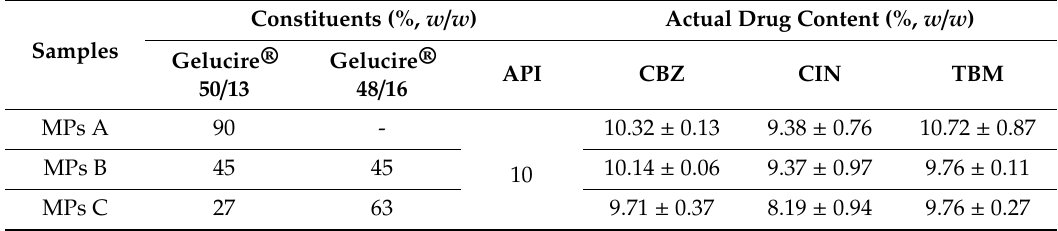
Table 1. Composition and actual drug content of the MPs A, MPs B, and MPs C loaded with CBZ, CIN, and